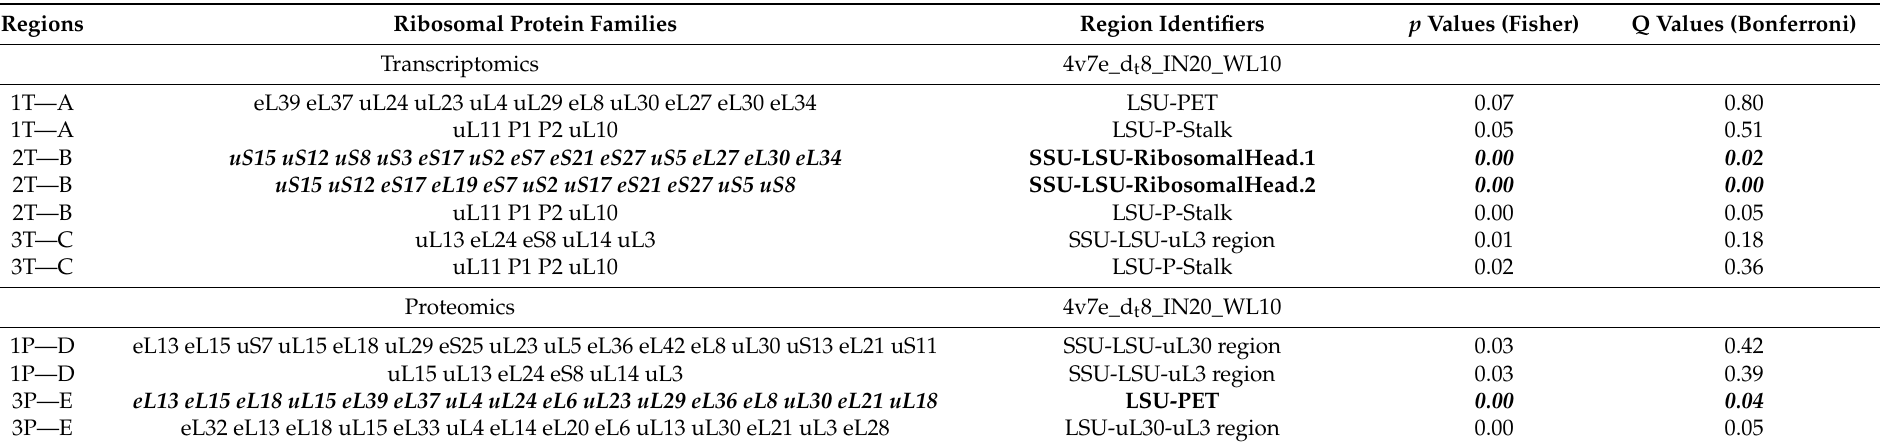
Table 2. Paralog abundance changes that imply significantly modulated regions during cold acclimation in plants. Different sources of omics data were interpreted in their structural context using the procedures detailed in the GitHub repository COSNet i (https://github.com/MSeidelFed/COSNet_i, accessed on 30 April 2021). The data tested were transcriptome (1T) inversely regulated, (2T) inverse and upregulated, (3T) inverse, down, and upregulated as detailed in Figure 3. Proteome (1P) 60S to polysome ratios, (2P) polysome or (3P) both instances as detailed in Figures 4 and 5. Multiple entries per test indicate that several regions tested significant according to a Fisher exact test comparing the proportion of RP significances within selected regions to the total amount of significances among